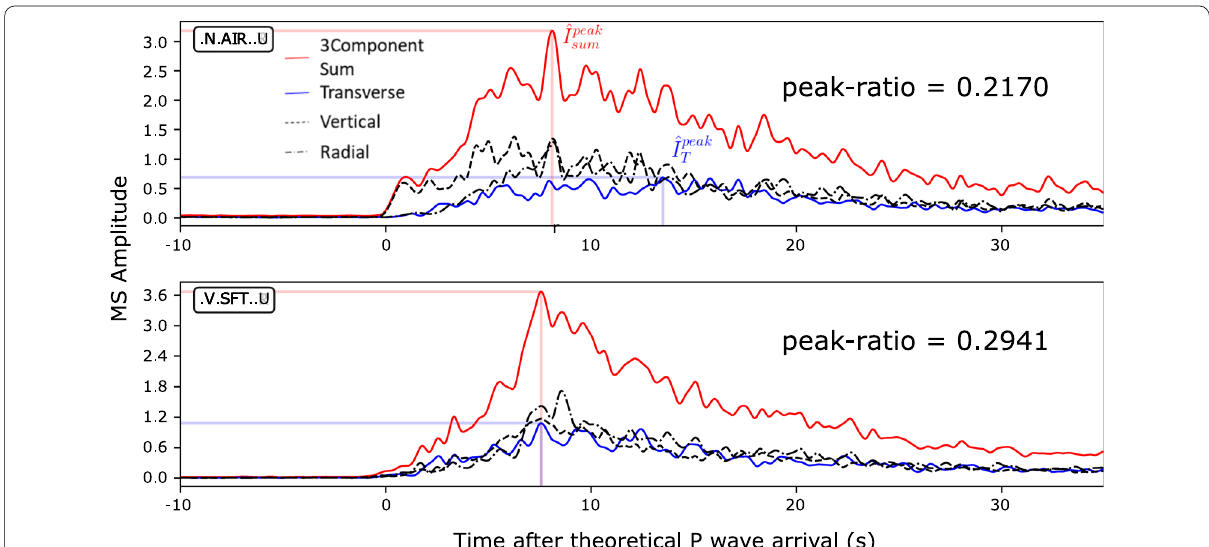
Fig. 1 Examples of the Mean-Squared (MS) seismogram envelope for the 2–4 Hz band. Shown are from station AIRH of the Hi-net network (top) and station SFT2 of the JMA network (bottom). These stations are chosen because both are borehole stations and both are close to the Sakurajima volcano. The blue traces signify the transverse component envelopes, while the red traces signify the three-component sum envelopes. The dash and dash–dot lines are the vertical and radial component envelopes, respectively. The translucent lines mark the peaks of the transverse and the three-component sum seismogram MS envelopes. They are denoted as (cid:31) I peak T and (cid:31) I peak sum , respectively, from which the peak amplitude ratio is calculated. Time is given in relation to the theoretical P wave arrival according to the ak135 model. Theoretical S wave arrival is outside the given time